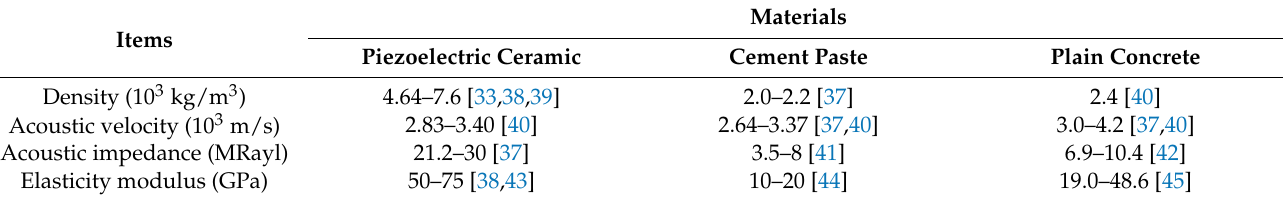
Table 1. Physical properties of piezoelectric ceramic, cement paste and